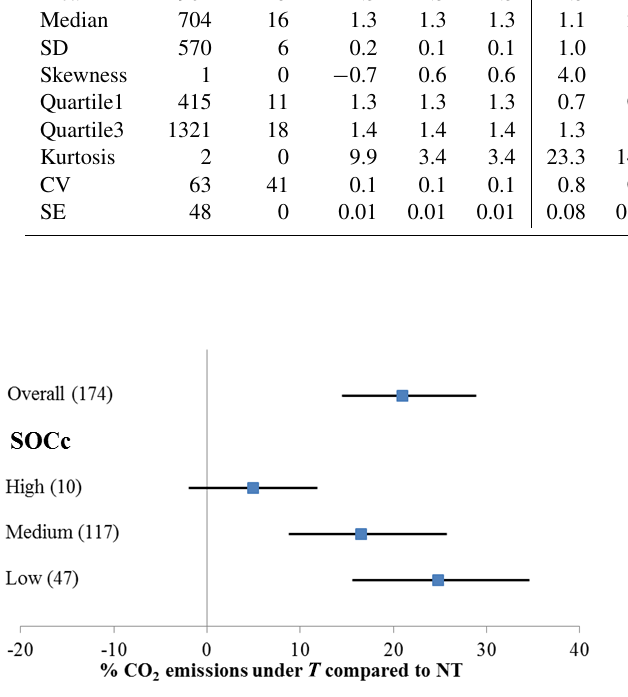
Figure 2. Percent change in CO 2 emissions in tillage ( T ) compared to no tillage (NT) as a function of SOC C (low, <10gkg − 1 , medium 10–30gkg − 1 , high >30 g kg − 1 ) . The numbers in the parentheses indicate the direct comparisons of meta-analysis. Error bars are 95% confidence